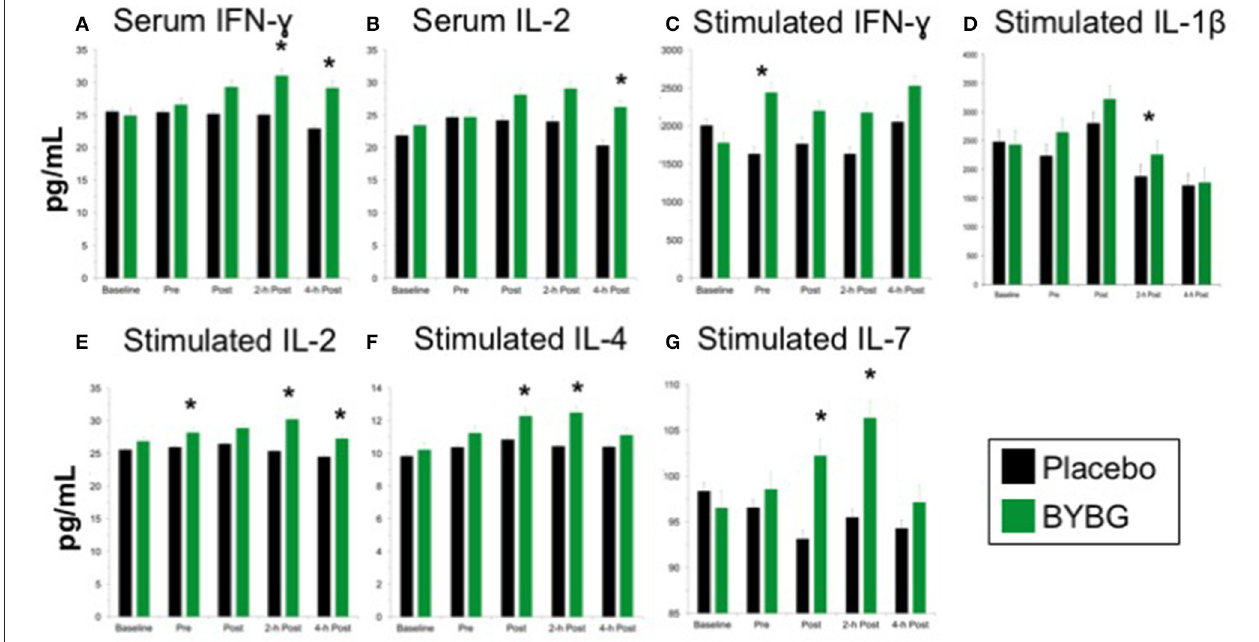
FIGURE 7 | Effect of BYBG on serum and LPS-stimulated cytokines. Cytokine concentrations were determined using a multiplex bead-based assay that was optimized for either low concentration serum (high-sensitivity kit) or tissue culture supernatant (standard sensitivity) samples. All samples were analyzed in duplicate. Of the measured cytokines, significant differences between BYBG and placebo were observed for serum IFN- γ (A) and IL-2 (B) . Differences were also observed for LPS-stimulated IFN- γ (C) , IL-1 β (D) , IL-2 (E) , IL-4 (F) , and IL-7 (G) . Values represent the mean ± SEM. *indicates BYBG significantly different than placebo ( p <